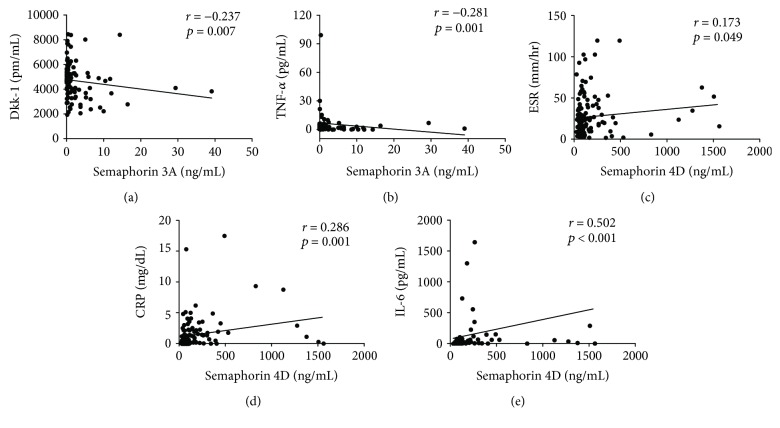
Associations of Sema3A and Sema4D levels with other biochemical data.